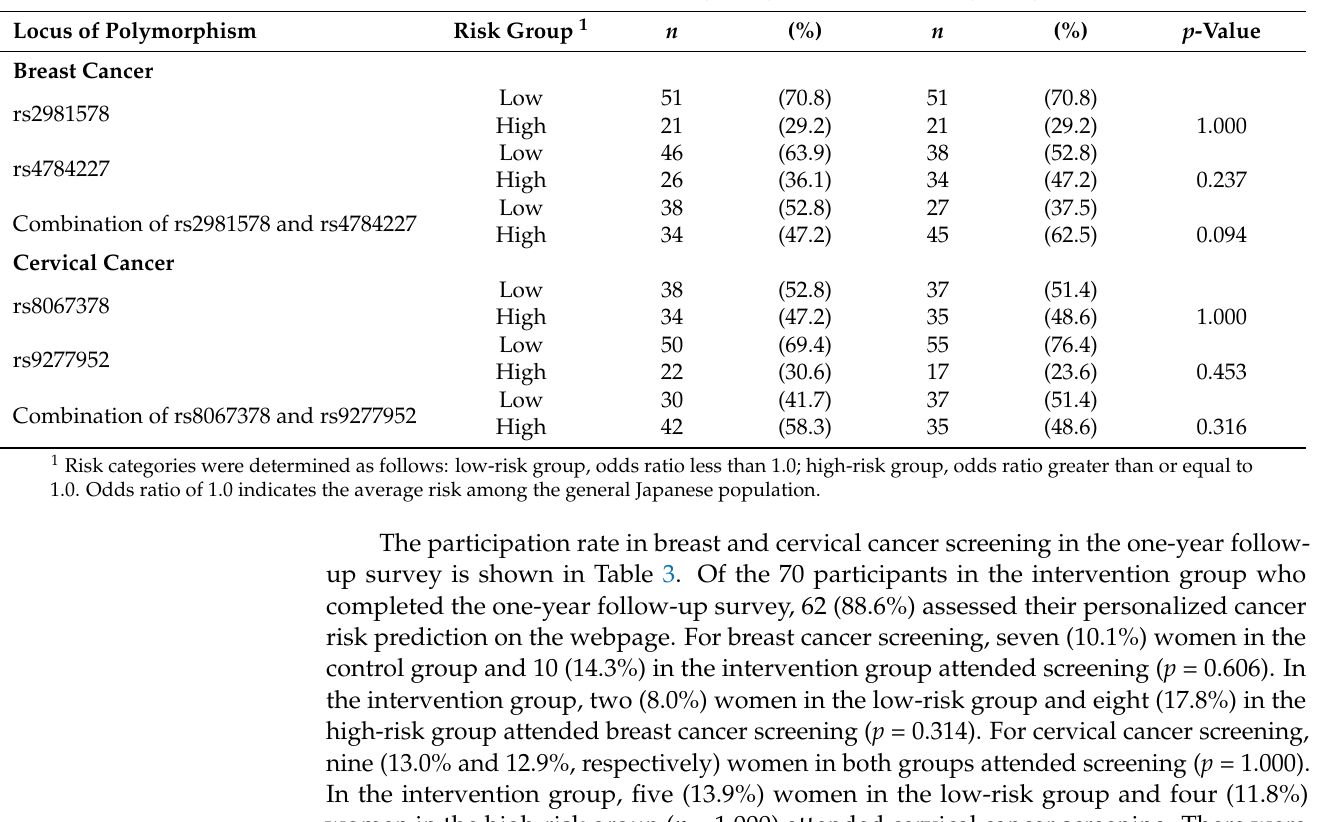
Locus of Polymorphism